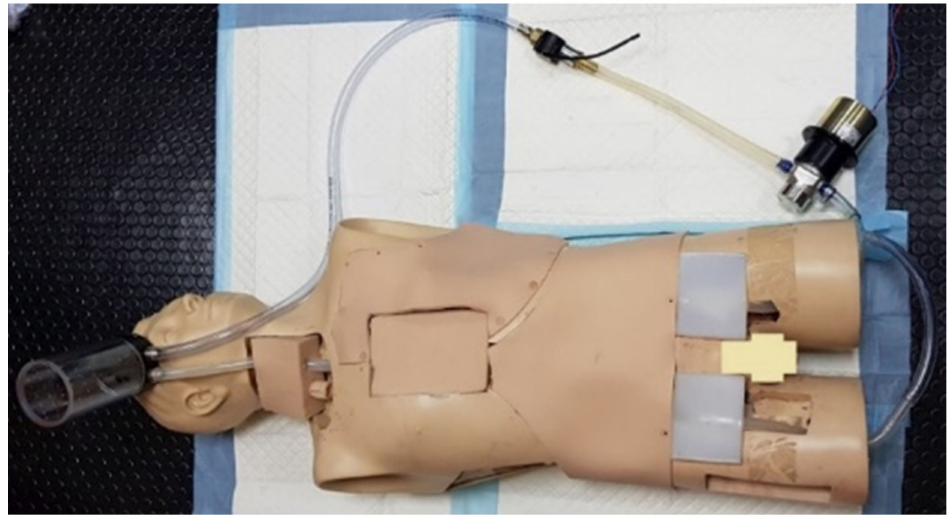
Figure 11. Next-generation cannulation simulator [22].